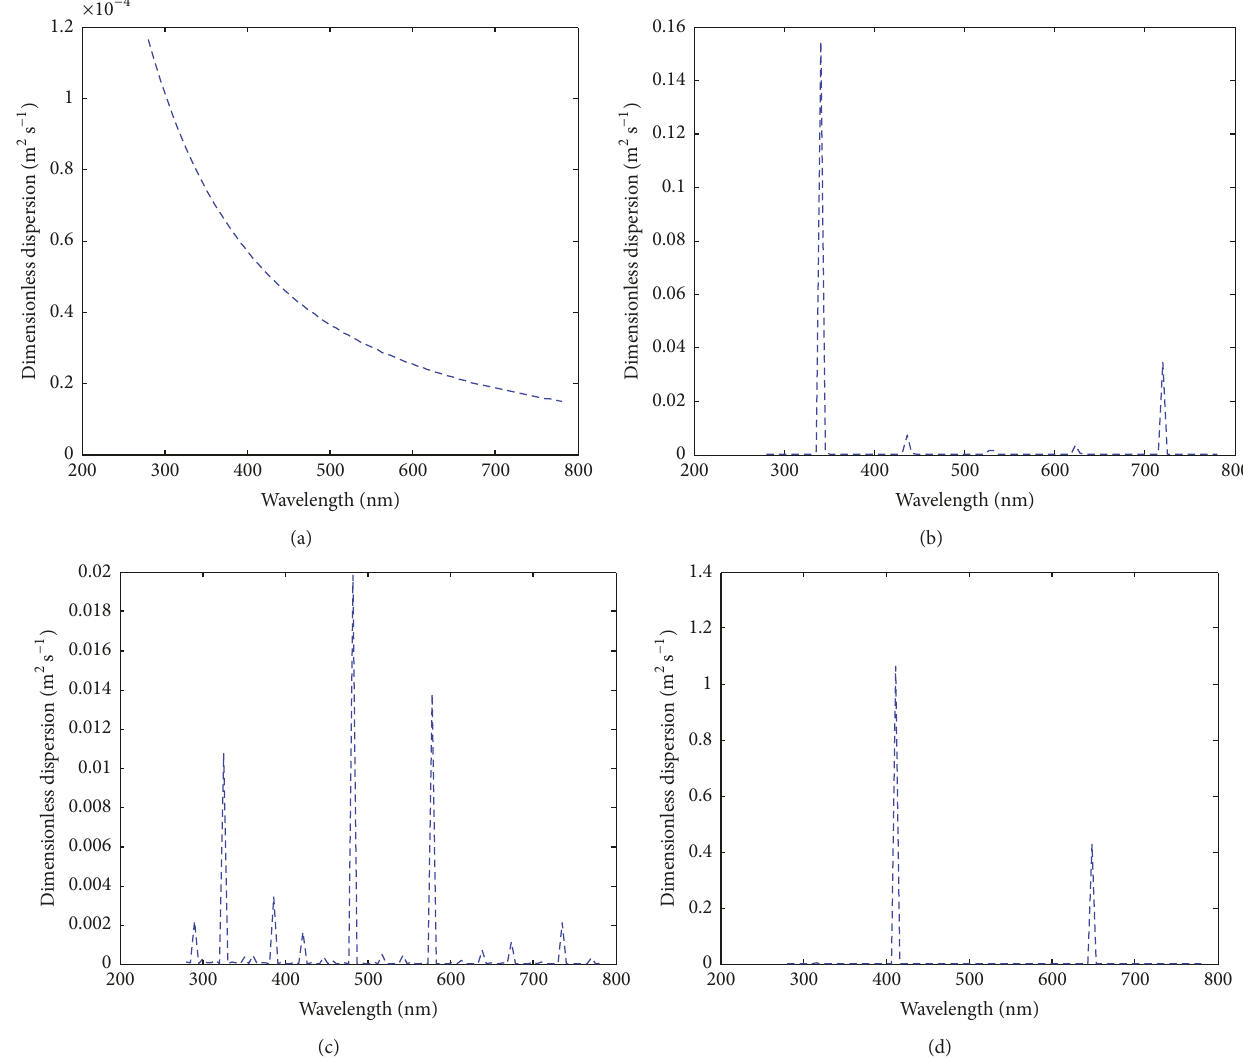
Figure 8: The dimensionless dispersion of the metallic nanoparticle under varying conditions (a) when Bragg’s angle of the nanoparticle is strictly 45 ∘ ; (b) when Bragg’s angle of the nanoparticle ranges between − 30 ∘ and 30 ∘ ; (c) when Bragg’s angle of the nanoparticle ranges between − 45 ∘ and 45 ∘ ; (d) when Bragg’s angle of the nanoparticle ranges between − 60 ∘ and 60 ∘ .